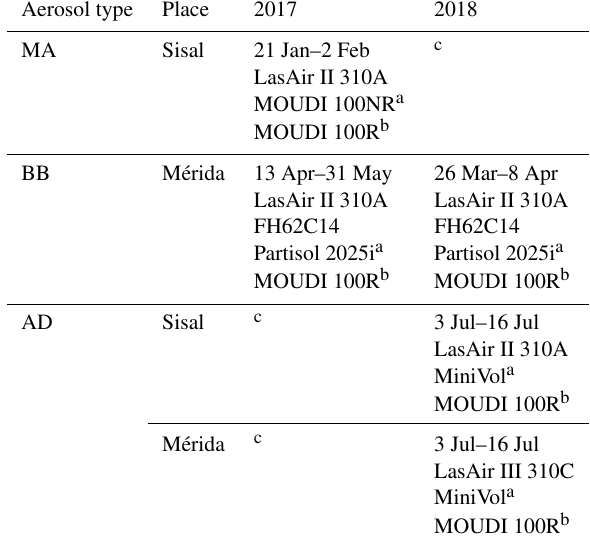
Table 1. Summary of the sampling periods, the instrumentation used, and the type of collected samples (for chemical composition and INP analysis) from Mérida and Sisal during 2017 and 2018. MA, BB, and AD refer to marine aerosol, biomass burning, and African dust, respectively. The a , b , and c denote the samples col- lected for chemical analysis, samples collected for INP analysis, and samples not collected during this period,